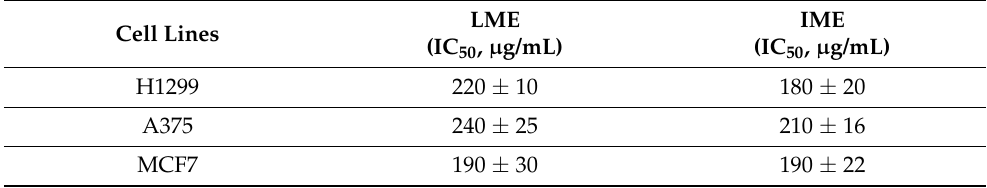
Table 9. IC 50 values of LME and IME in human cancer cell